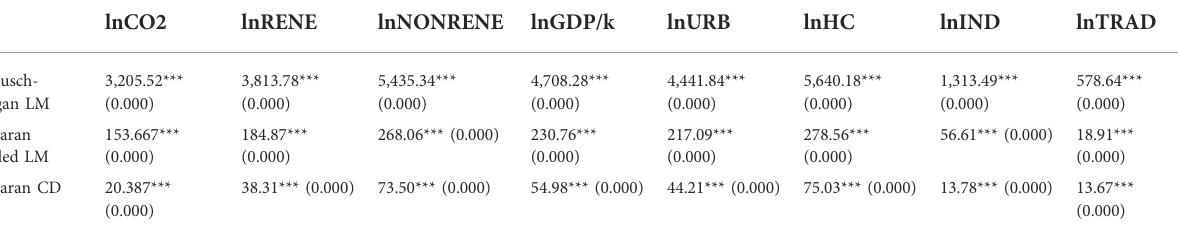
TABLE 5 The cross-dependence tests.